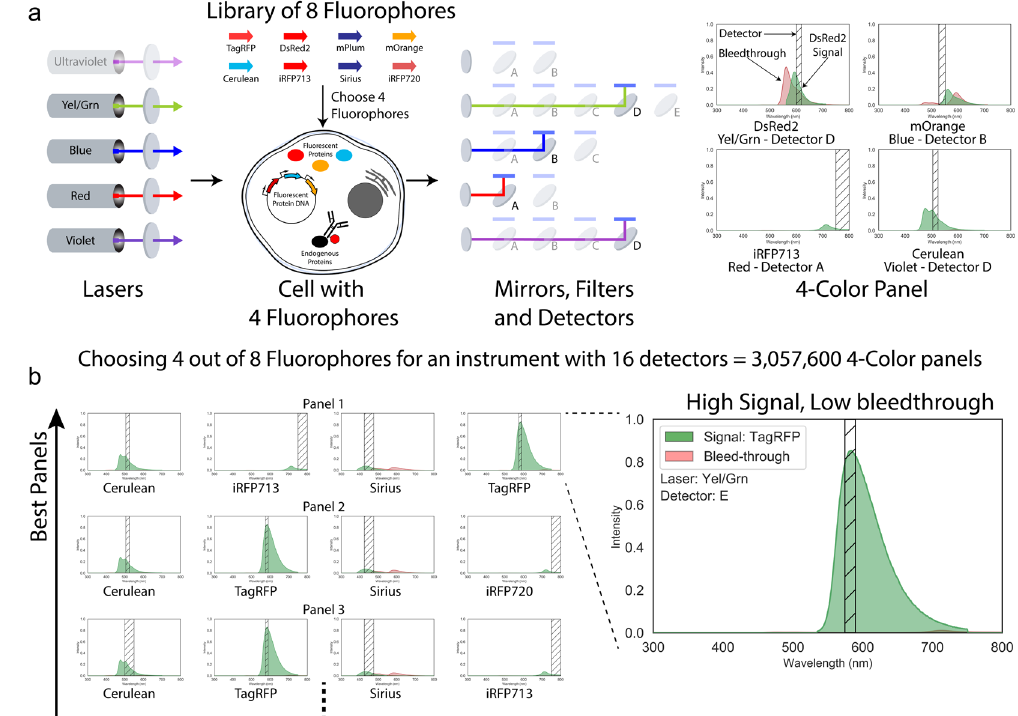
Fig. 1 Selecting 4 fl uorophores from a library of 8 fl uorophores on a fl uorometry machine with 16 detectors. a Fluorophores can include fl uorescent proteins, dyes, and conjugated antibodies. The light created by illuminating these fl uorophores is generally activated with lasers of speci fi c wavelength and captured by detectors that accept certain ranges of light signal on either a microscope or PMTs. The libraries of possible fl uorophores to use and possible machine settings to detect the light are vast and present a problem dif fi cult or impossible to properly optimize using ad hoc techniques. b In this case, selecting just 4 fl uorophores from a library of 8 for this speci fi c instrument is intractable since there are over 3 million possible 4-color panels, of which only 0.7% are valid. Even among the valid panels, a few con fi gurations may be sub-optimal due to high bleed-through and low signal in the detector as shown in the middle plot on the right. Our algorithms can optimize the panel design by maximizing the signal in each detector and minimizing bleed- through (like the plot on the top right).